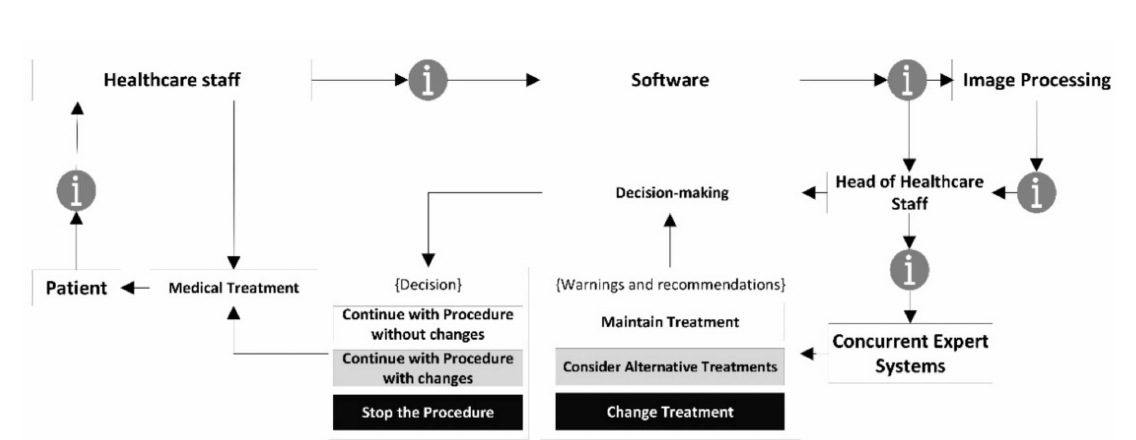
Figure 1. Conceptual schematic of the artifact showing the information